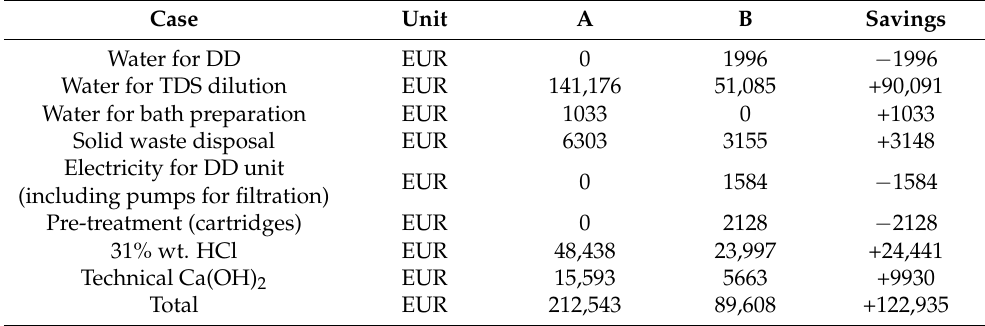
Table 7. Annual expenses for each case of the economic study. ( A ) Processing spent 10% wt. HCl without DD; ( B ) processing spent 10% wt. HCl with